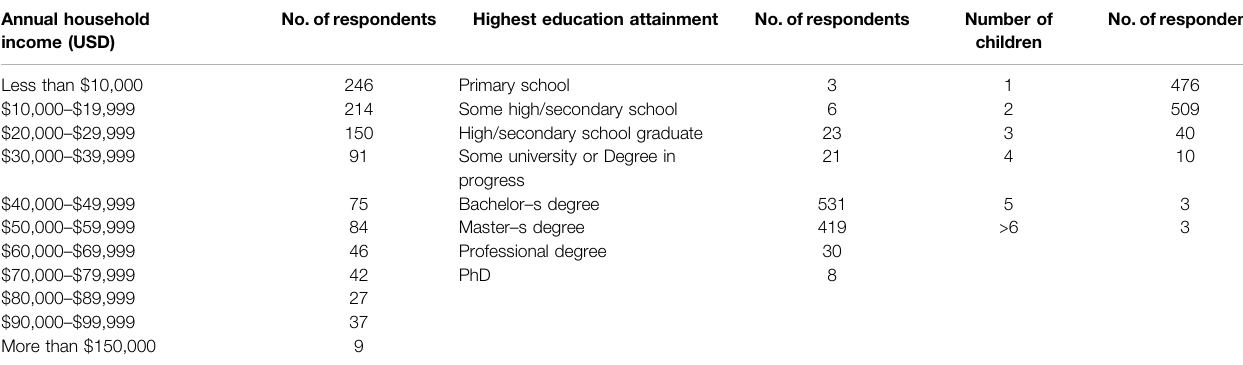
TABLE 1 | Background information of the sample. Annual household income (USD)